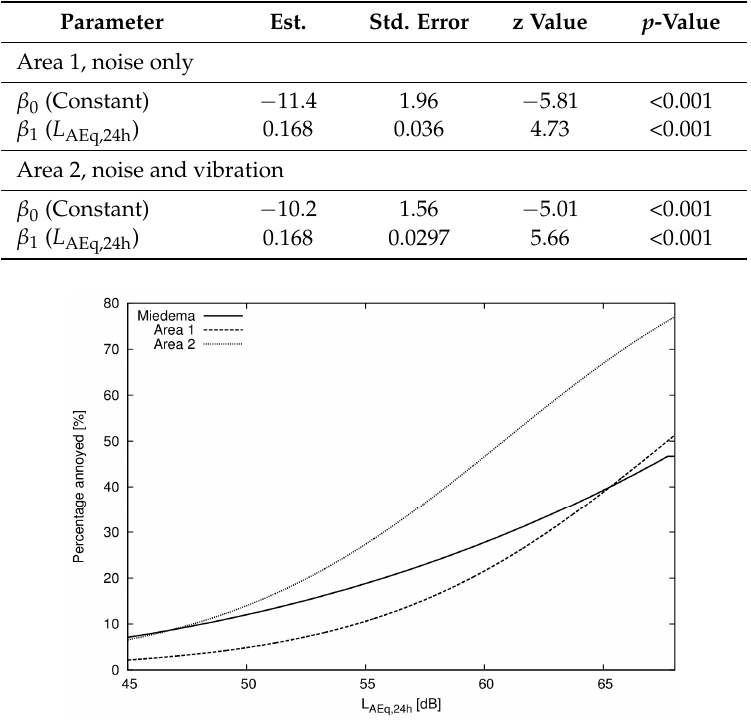
Figure 3. Annoyance from railway traffic noise estimated from area 1 (noise only) and area 2 (noise and vibration) compared to results from Miedema and Oudshoorn [12].